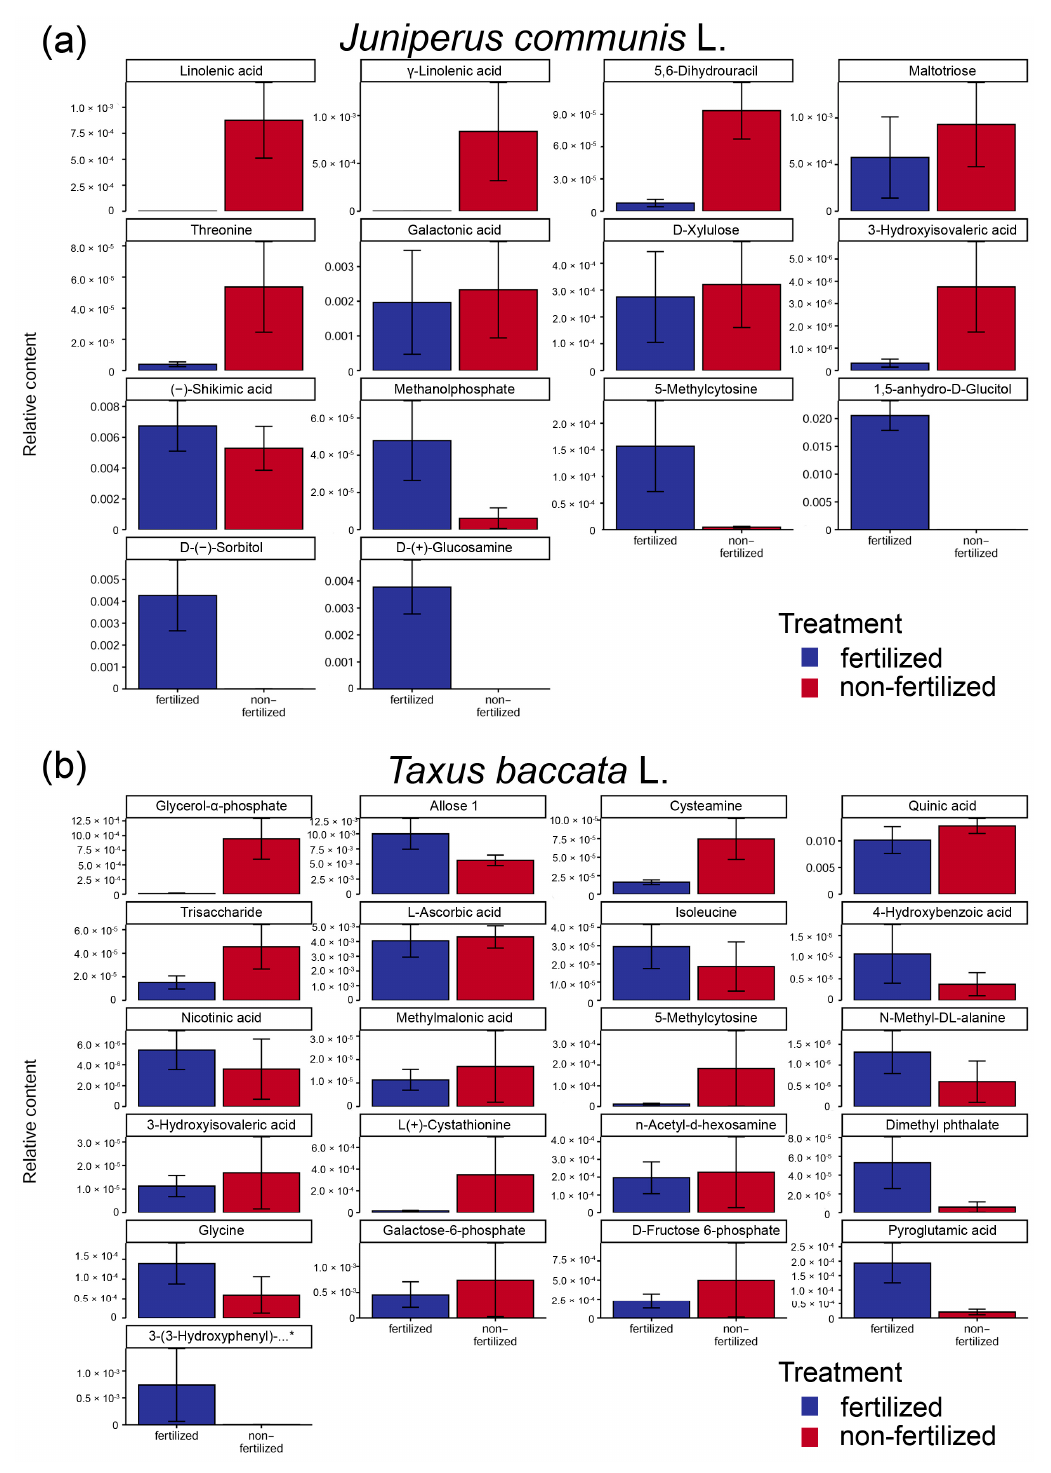
Figure 7. Y-axis shows the differences among the relative content of differentiated metabolites between pollen grains produced by long-term fertilizer-supplemented male individuals of ( a ) Juniperus communis L. and ( b ) T. baccata plants. Dark blue and red color shows the relative content of metabolites in pollen grains produced by fertilized and non-fertilized plants, respectively. 3-(3-Hydroxyphenyl)- . . . * indicates 3-(3-Hydroxyphenyl)-3-hydroxypropionic acid. Vertical bars represent standard error among five independent replicates. Data are the mean ± SEM of five replicates. All metabolites were significantly different at p <